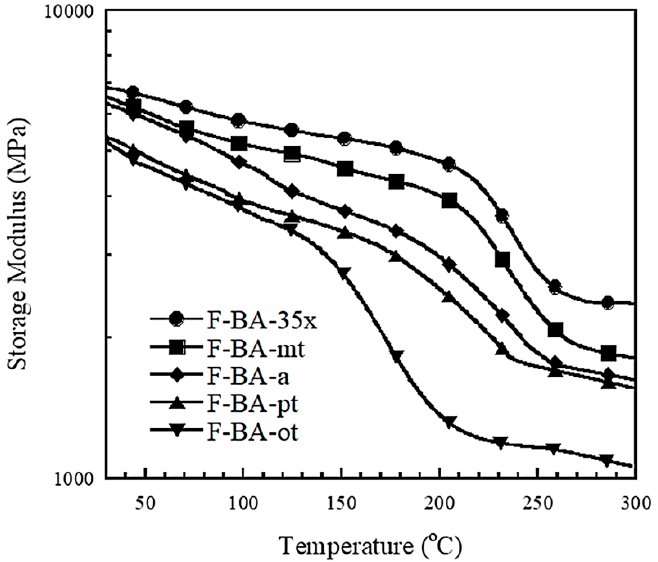
Figure 1. Storage modulus as a function of the temperature of polybenzoxazine composites prepared from different benzoxazine resins.